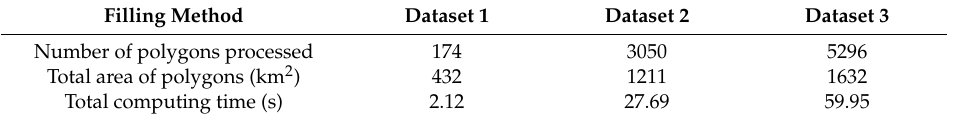
Table 2. Comparative analysis of the computing time of methods applied to the large data